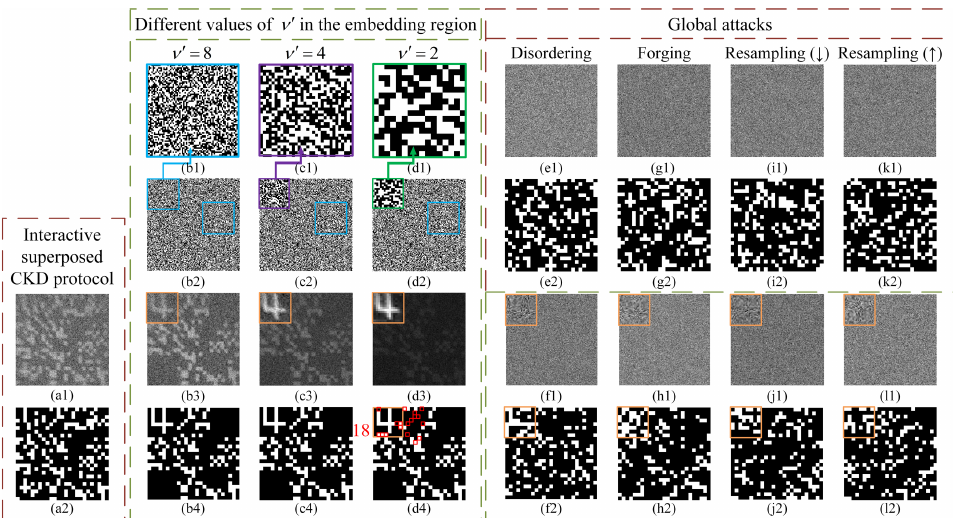
Figure 6. Results of two CKD protocols based on computational ghost imaging (CGI) under differ- ent ν (cid:48) values and different global attacks. ( a1 , a2 ) The recovered ghost image and binarized result of FP random by using the interactive superposed CKD protocol. ( b1 – b4 , c1 – c4 , d1 – d4 ) are the en- larged watermark-embedding regions of the modulated patterns; the complete matrices of these patterns; and recovered ghost images of FP 4 and their binarized results, acquired using the proposed protocol, with different ν (cid:48) values in the watermark-embedding region—8, 4 and 2, respectively. ( e1 , e2 , g1 , g2 , i1 , i2 , k1 , k2 ) in the brown dotted box and ( f1 , f2 , h1 , h2 , j1 , j2 , l1 , l2 ) in the green dotted box are the restored ghost images and their binarized images corresponding to the interactive superposed CKD protocol and our protocol under different global attacks (disordering, forging, resampling (sub-resampling) and resampling (over-resampling)),